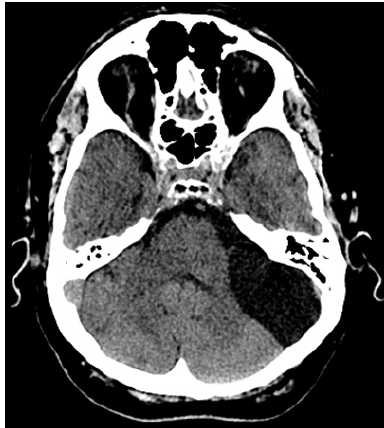
Figure 1. Head computed tomography (CT) scan revealing a large left extra-axial cystic lesion that was being monitored before current